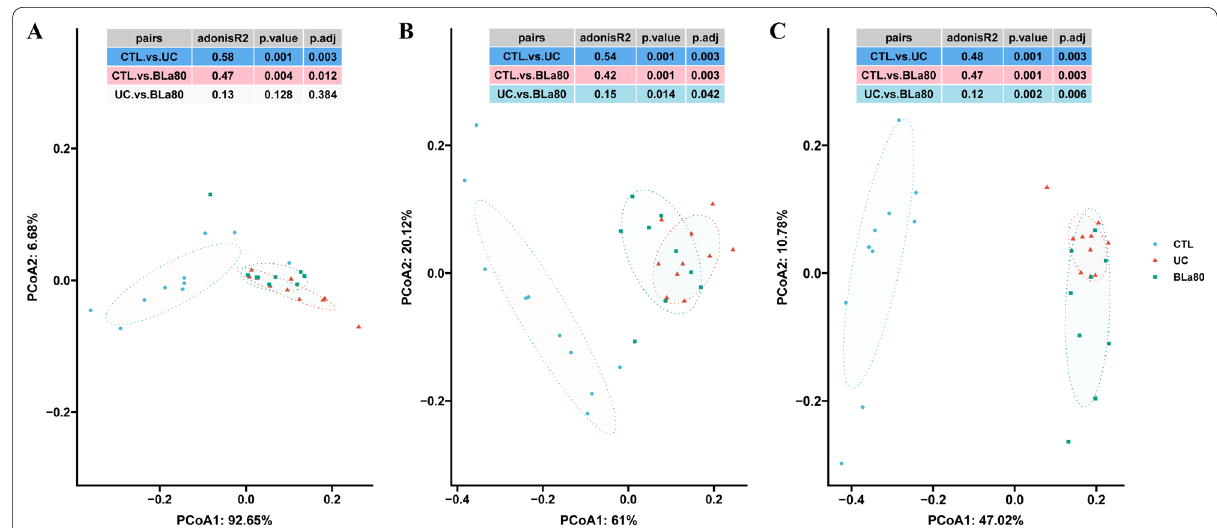
Fig. 4 Effect of BLa80 on gut microbiota in UC mice. The composition distribution patterns under different taxonomic classifications including phylum ( A ), family ( B ) and genus ( C ) levels were compared using PCoA. We also performed a significance analysis using pairwise